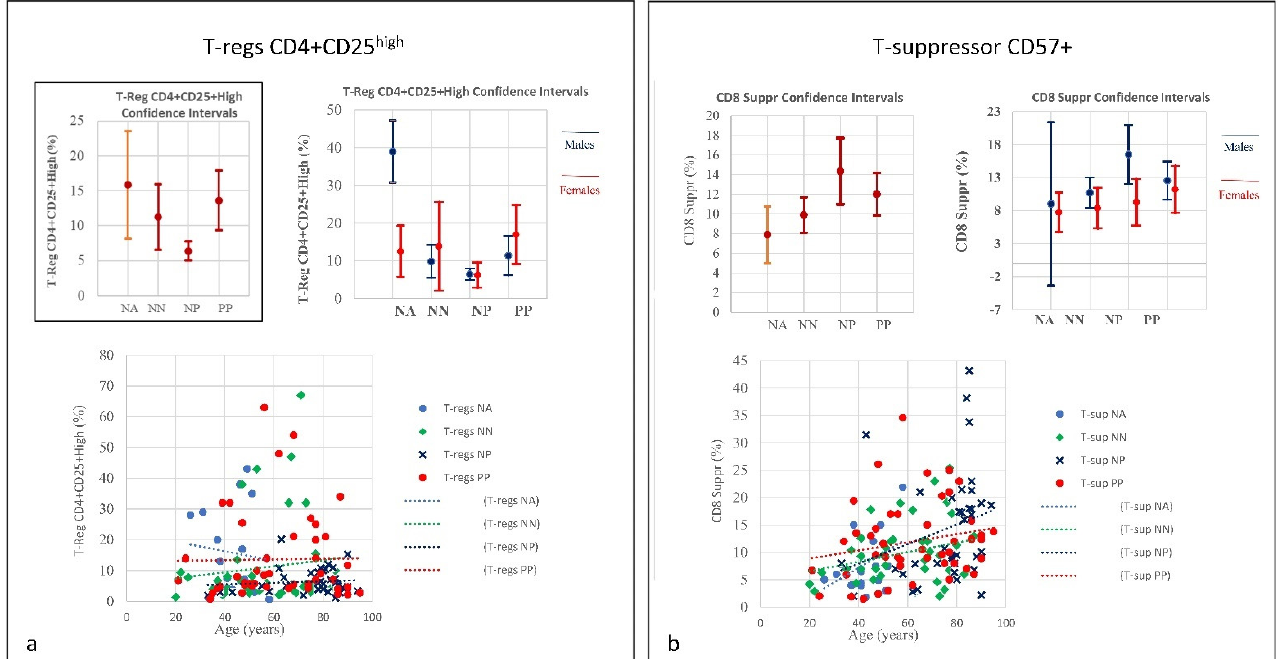
Figure 8. ( a ) Frequencies of T-regs CD4+CD25 high in COVID-19 patients and controls (NP, NN and NA) (CI 95%). Frequencies of T-regs in COVID-19 patients indicate a quantitative linearity without correlation to age. Similarly, the NP group showed the lowest quantitative level of T-regs with a correlation to age. The NN group was observed in between the PP and NP groups. The prominent point of severe COVID-19 is determined by an uncontrolled pro-inflammatory cytokine activity, the so-called “cytokine storm” that is in part due to deficiencies in immune regulatory mechanisms of T-regs key regulators of immune responses which are essential in the maintenance of immune homeostasis. The T-regs modulate the antiviral defense at the early stage of infection and reduce inflammation at the late stage of COVID-19. Right: Frequencies of T-suppressor CD57+ in COVID-19 Patients and Controls (NP, NN and NA) (CI 95%). ( b ) Frequencies include totality and divided by gender. T-suppressor quantitative increase in PP and NP correlating to age. In the NP group one can see that, quantitatively, the NP showed the highest rate of T-suppressors in elderly patients; the T-suppressors also increase in NN but in this case there is no correlation to age. The graphic indicates greater uniformity among the individuals. The original function of T-suppressor is blocking the activity of some other types of lymphocytes, to keep the immune system from becoming over-active. T-suppressor CD8+CD57+ also plays a significant role in various diseases or conditions, associated with chronic immune activation such as cancer, chronic intracellular infections, and some chronic pulmonary diseases.